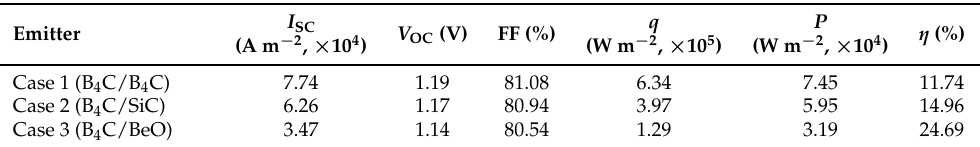
Table 1. Parameters for the TPV system based on scenario 2 ( h 3 = h 4 = 50 nm, w / Λ = 0.2), including short circuit current I SC , open circuit voltage V OC , fill factor (FF), total heat flux q , output power P and conversion efficiency η . The separation gap is 100 nm.